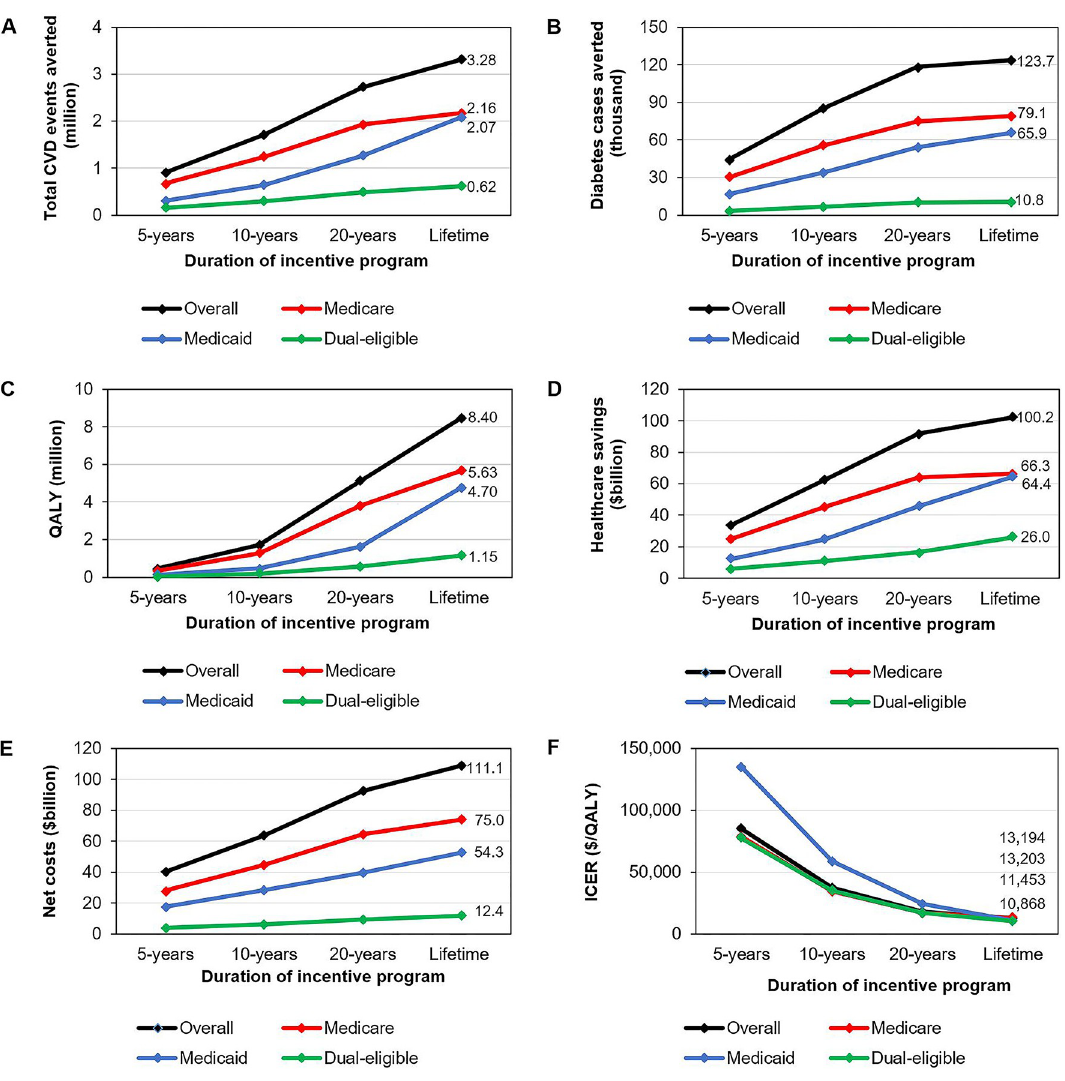
Fig 2. Estimated reductions in total (A) CVD events averted, (B) diabetes cases averted, (C) QALYs, (D) healthcare savings, (E) net costs, and (F) ICER of the 30% healthy food incentive program through Medicare and Medicaid by insurance type over 5, 10, and 20 years and lifetime. Values are shown from a healthcare perspective. Numbers indicate the values for lifetime analysis. ICERs were calculated as the change in net costs (policy costs minus healthcare savings) divided by the net change in QALYs. CVD, cardiovascular disease; ICER, incremental cost-effectiveness ratio; QALY, quality-adjusted life year.